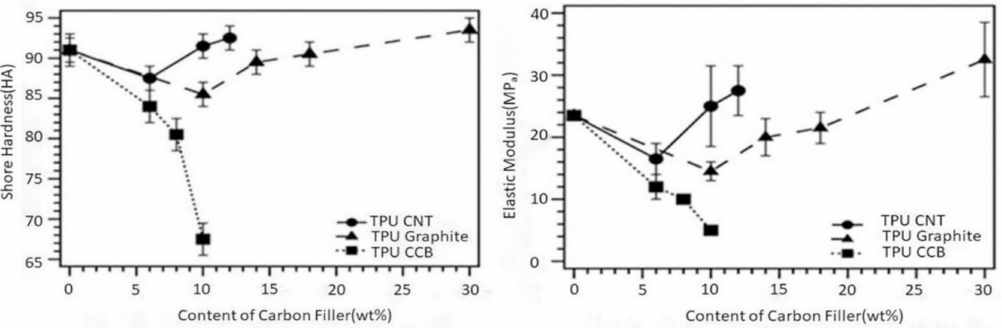
Figure 5. Shore hardness of TPU / C composites ( left ) and elastic modulus of C / TPU composites ( right